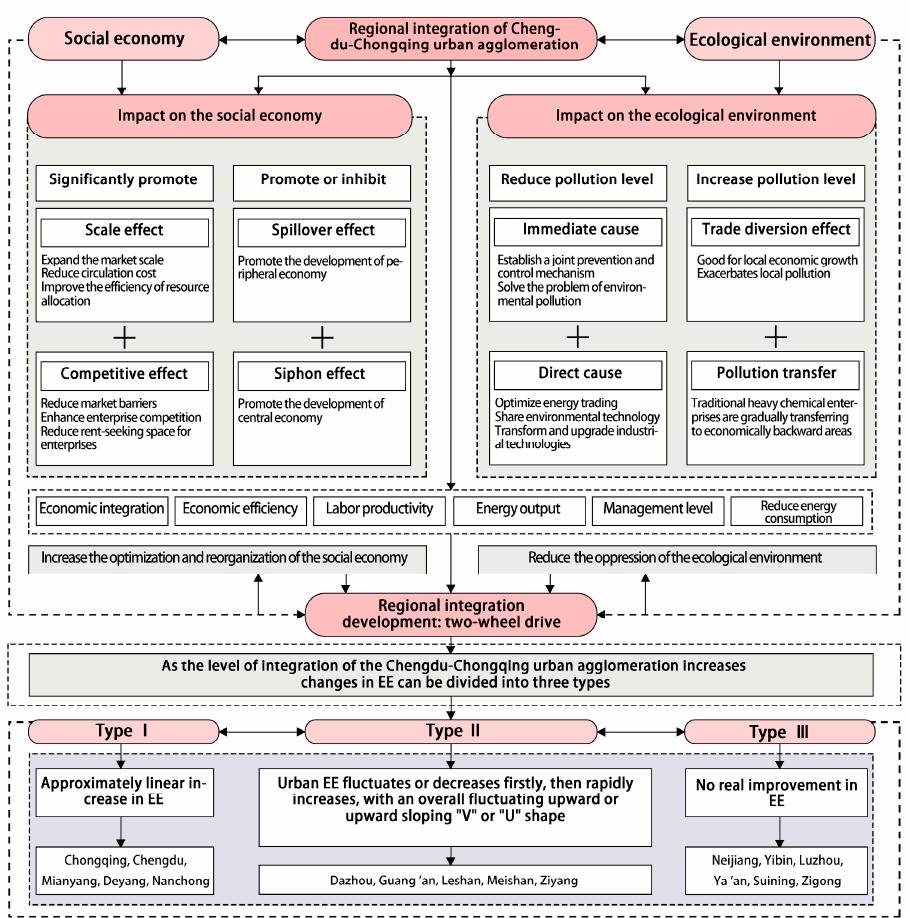
Figure 7. The impact of the integration of the CCUA on the EEs of cities in the region.